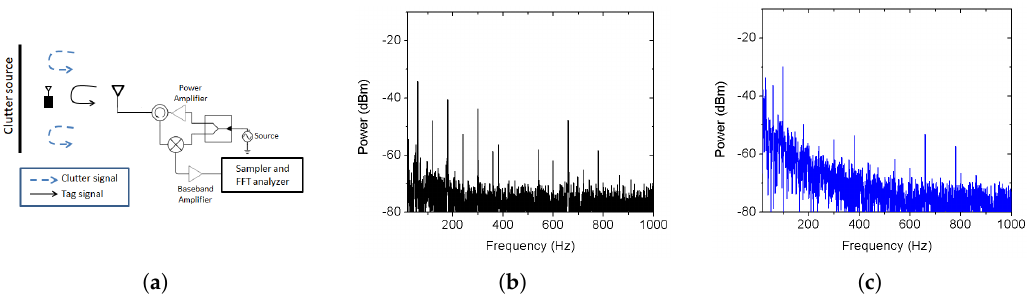
Figure 2. ( a ) The reader circuit to measure the clutter, ( b ) clutter phase noise in presence of an absorber, and ( c ) clutter phase noise in the presence of a clutter source [27]. [Reproduced with permission from S. Mondal, Scope and application of harmonic RFID for implanted body area network; published by IEEE,